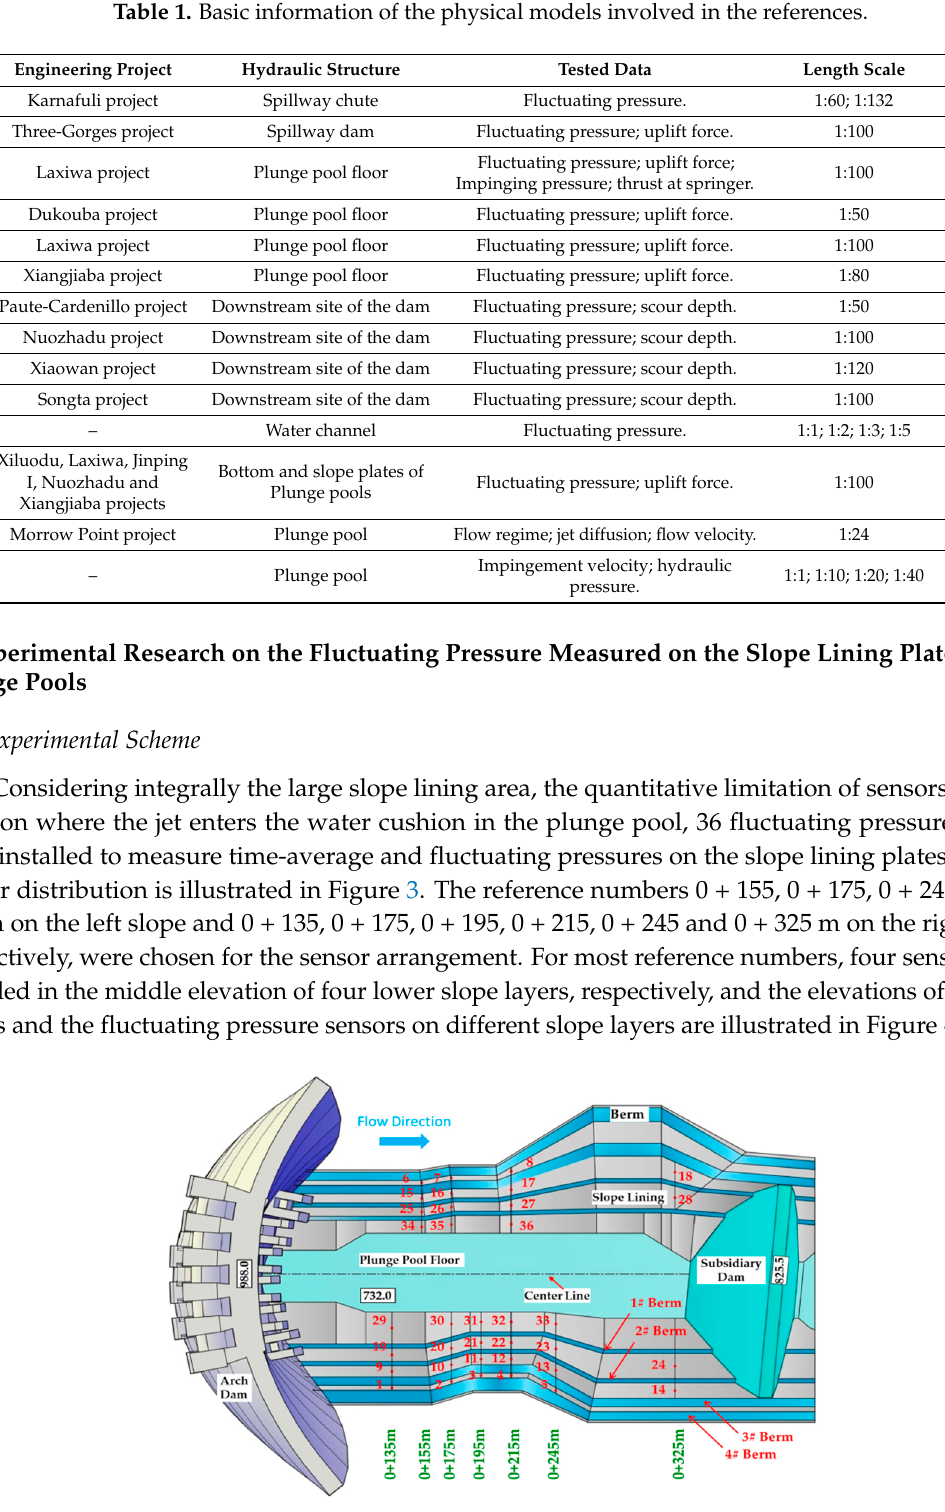
Figure 3. Arrangement of the fluctuation pressure sensors on the slope lining plate in the plunge pool.